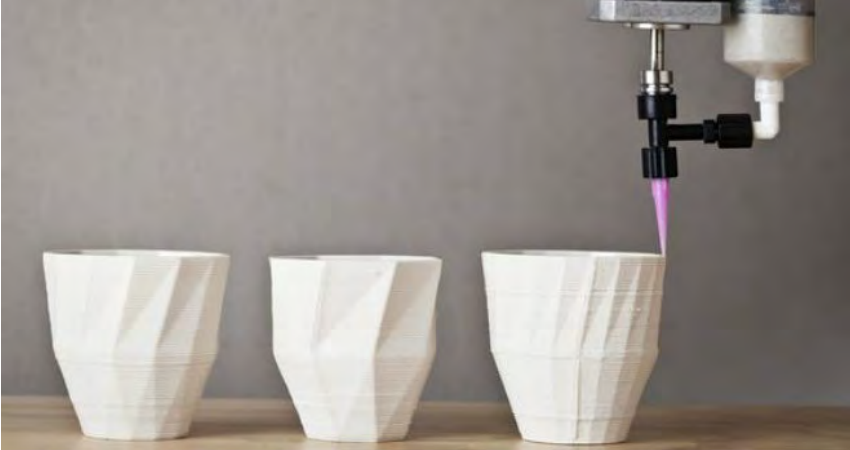
Figure 1. 3D printed